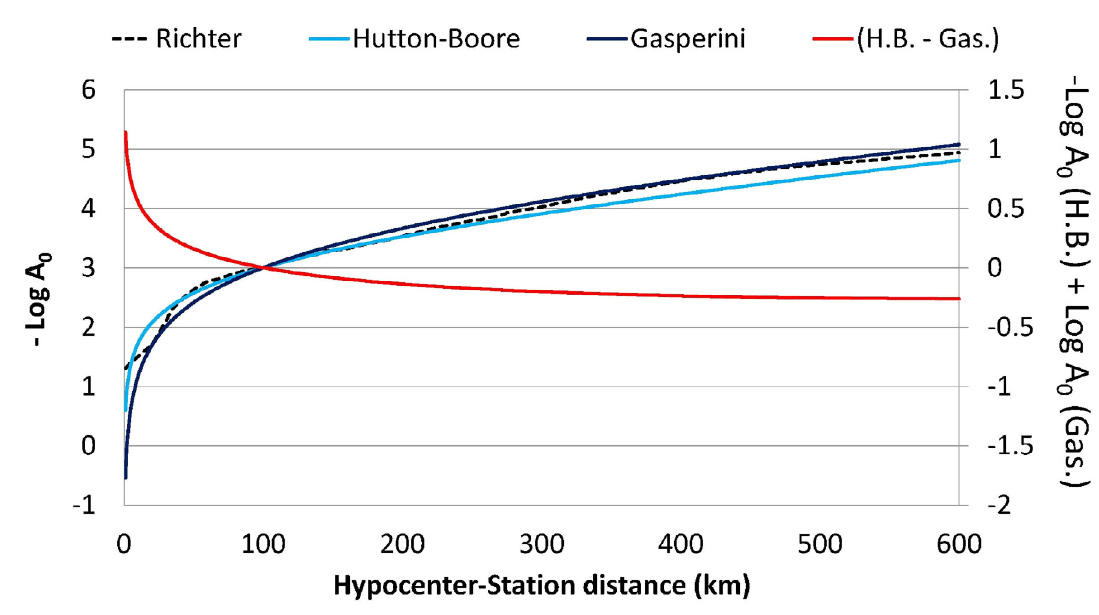
) by Richter (black dashed line), by Hutton and Boore (cyan line), and by Gasperini (dark blue line), and the dif- Figure 6. Distance correction ( – Log A 0 ference between the Hutton and Boore and the Gasperini corrections (red line, secondary vertical